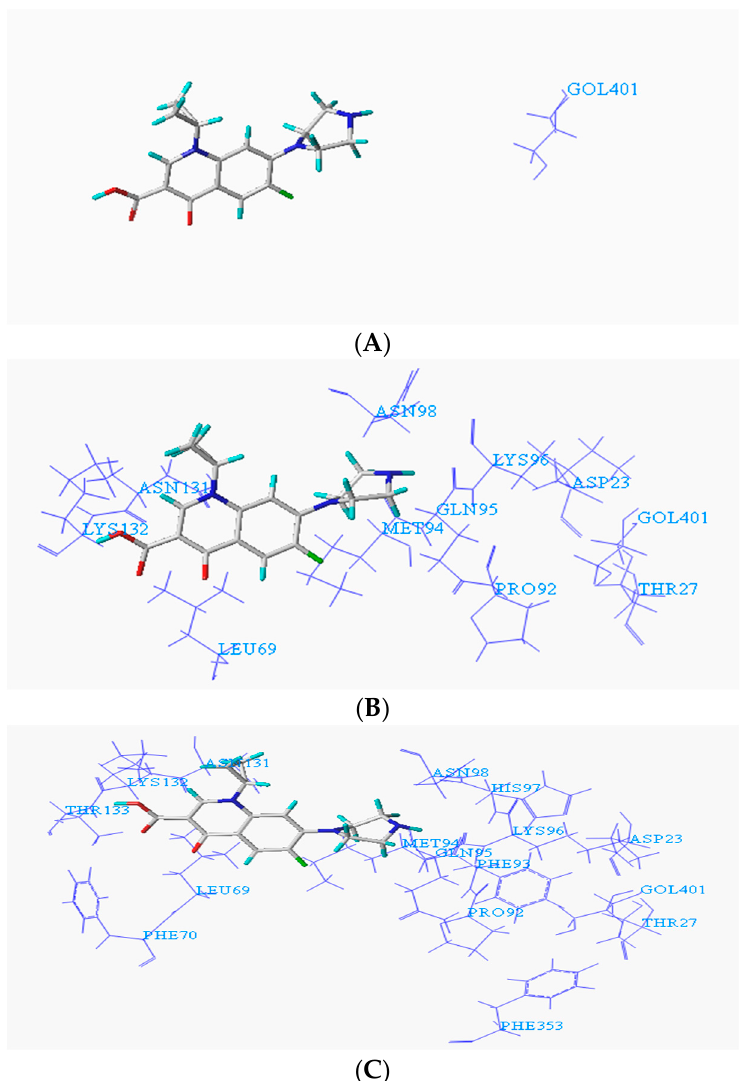
Figure 1. Conformation of ciprofloxacin (CIP) and degrading enzyme (PDB ID: 1YZP). ( A ) Within 1Å (GOL401); ( B ) Within 2Å (ASP23, THR27, LEU69, PRO92, GLN95, LYS96, ASN98, ASN131, LYS132, GOL401); ( C ) Within 5Å (ASP23, THR27, LEU69, PHE70, PRO92, MET94, GLN95, LYS96, HIS97, ASN98, ASN131, LYS132, THR133, PHE353).